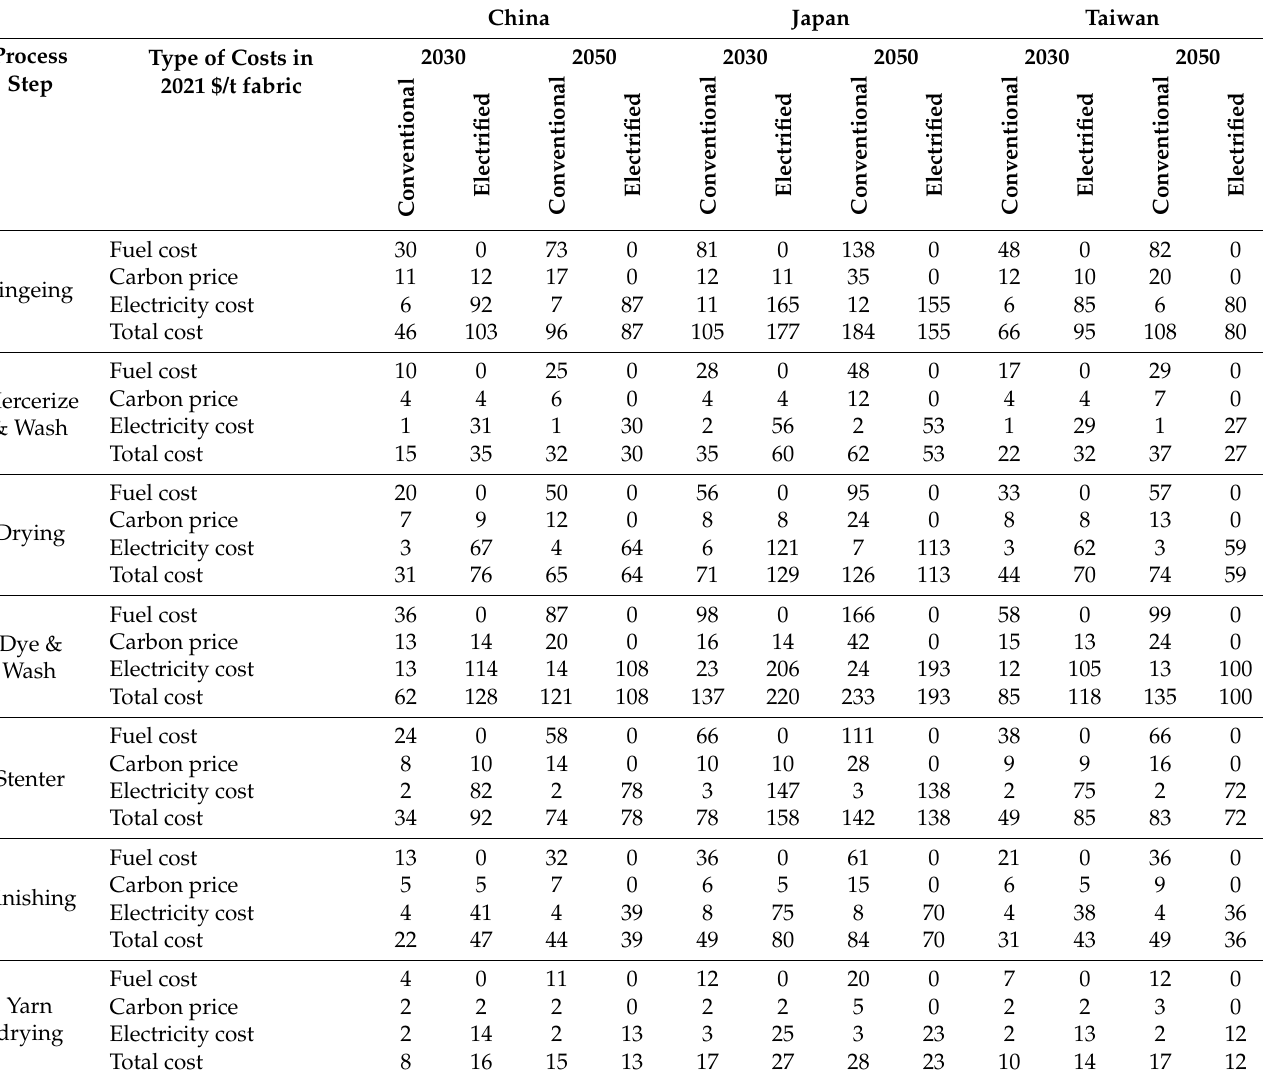
Table 9. Energy cost per unit of production (2021 $/t fabric) for conventional and electrified textile wet processes.